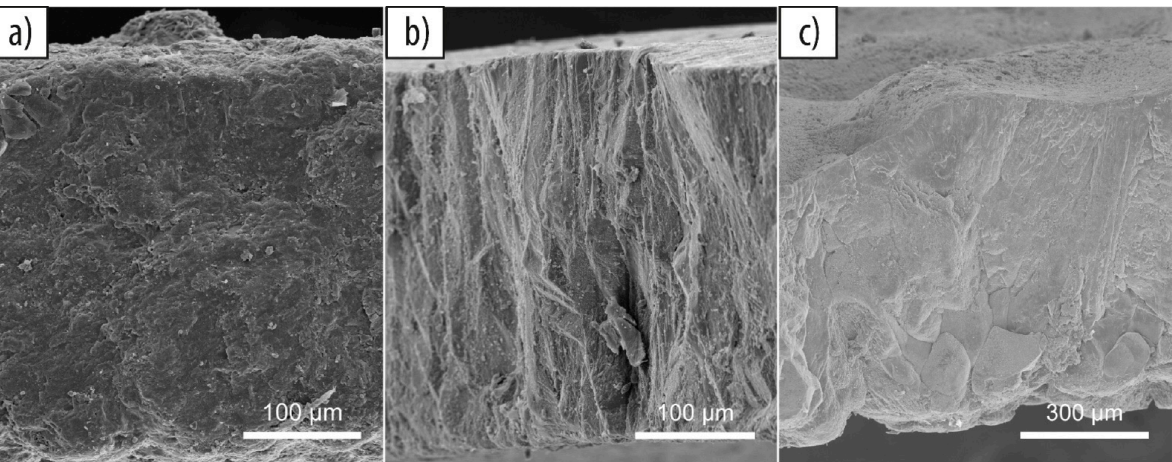
Figure 6. Tetrapod eggshells from the Western Tremp Syncline. ( a ) Pseudogeckoolithus sp. from the Blasi 2B site; ( b ) Prismatoolithidae indet. from Blasi 2B; ( c ) Krokolithes sp. from the Veracruz 1